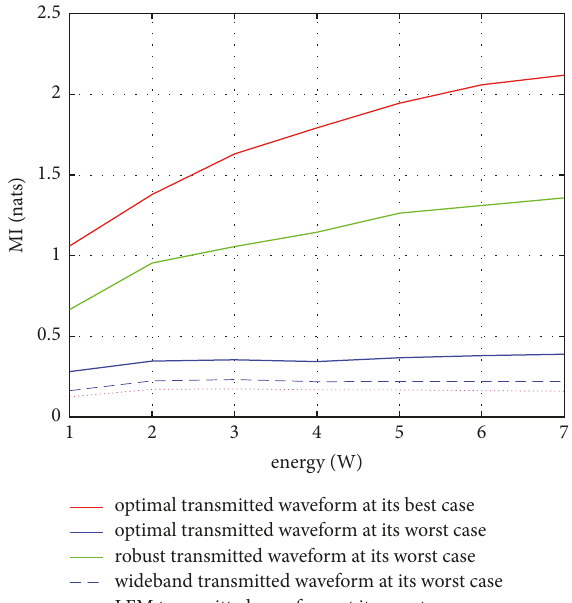
Figure 13: MI performance of the transmitted waveform results for single target.